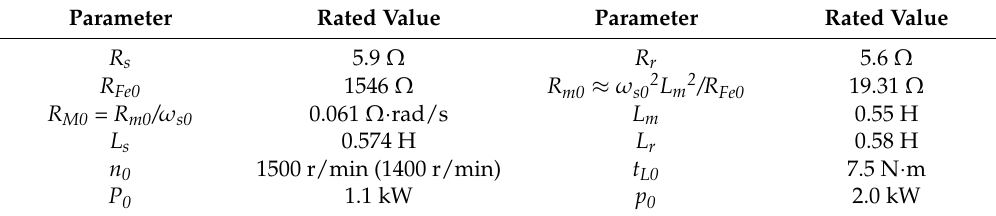
Table 2. Rating parameters of the motor used in simulation.